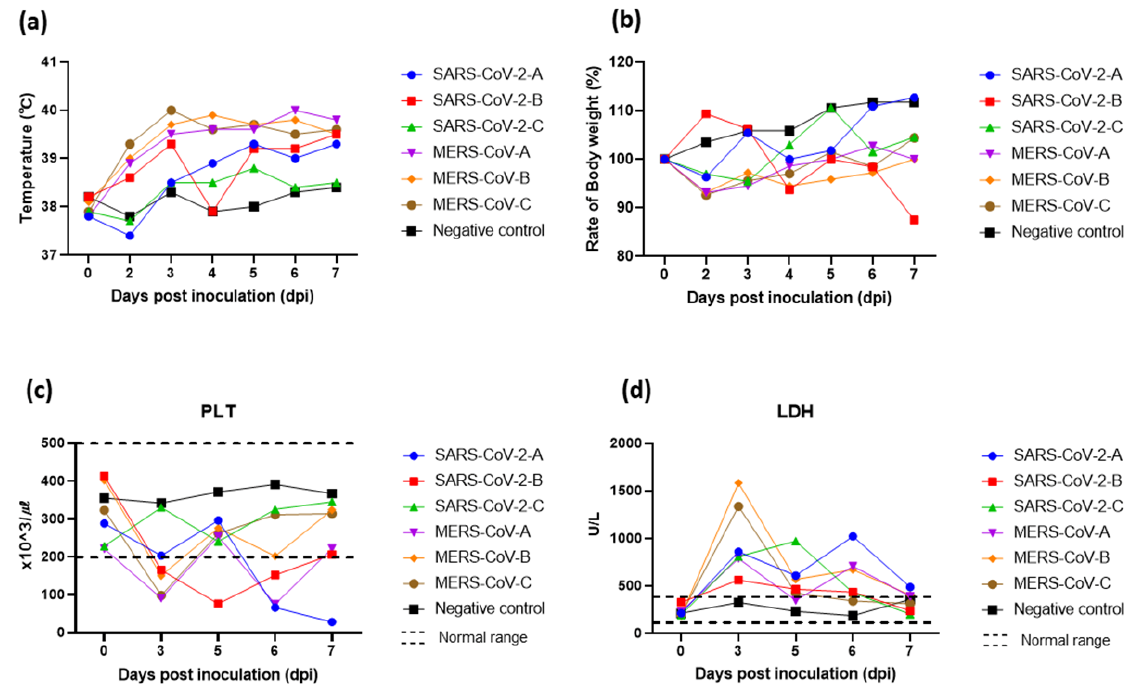
Figure 1. Body temperature changes, weight loss, platelet count (PLT), and lactate dehydrogenase (LDH) levels of dogs inoculated with SARS-CoV-2 or MERS-CoV. Three beagle dogs in each group were inoculated intra-nasally with SARS-CoV-2 (10 5.5 TCID 50 /mL) or MERS-CoV (10 5.5 TCID 50 /mL). ( a ) Temperature change; ( b ) weight loss; ( c ) PLT: platelet count; and ( d ) LDH: lactate dehydrogenase.